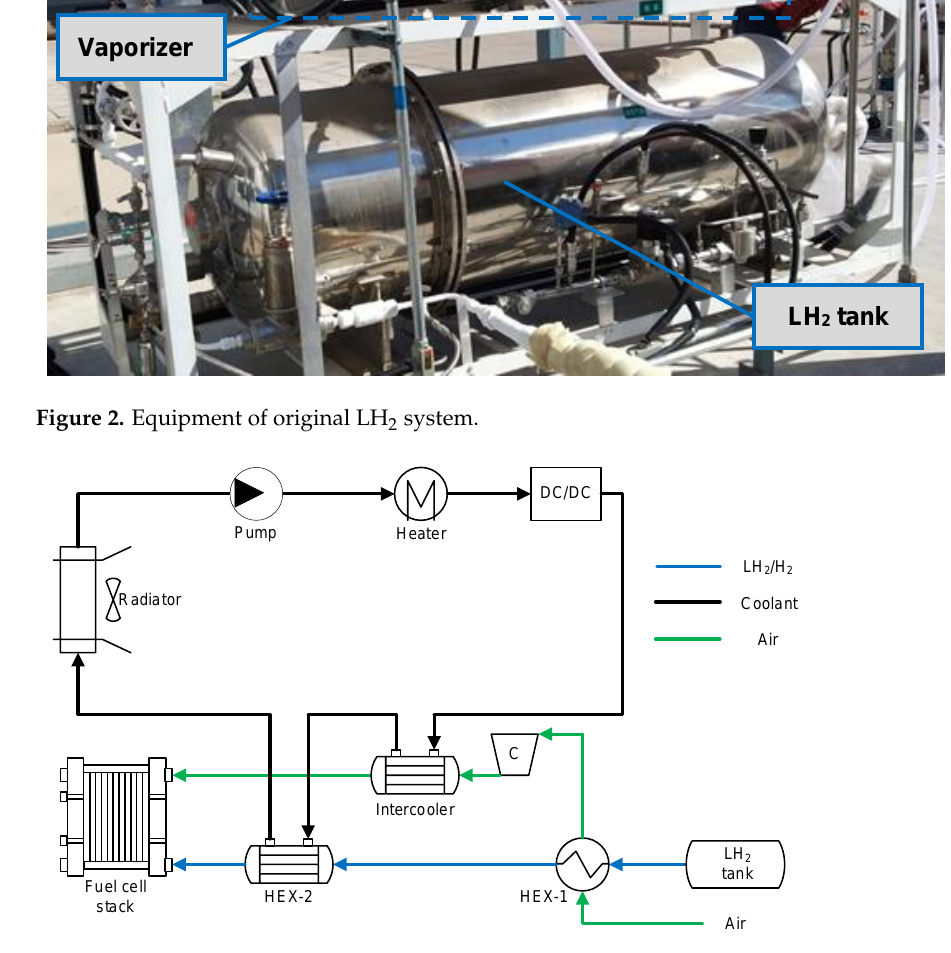
Figure 3. Scheme of LH 2 cold energy utilization system.